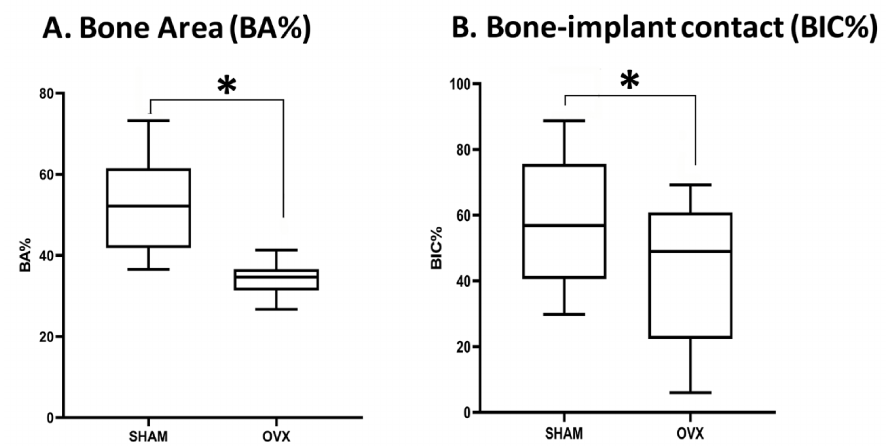
Figure 6. Box-and-whisker plot shows that the histomorphometrical, A, bone area (BA%) and, B, bone-to-implant contact (BIC%) around implants were significantly lower in OVX compared to SHAM rats. (* indicates p <